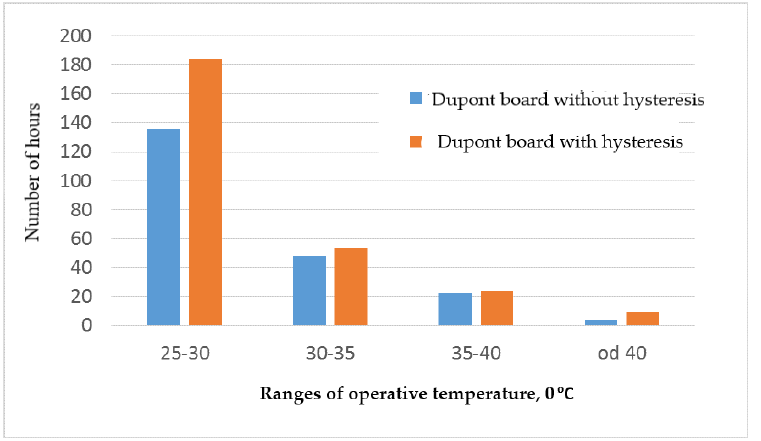
Figure 12. The time of occurrence of the operative temperature in individual ranges in the variant with a Dupont board